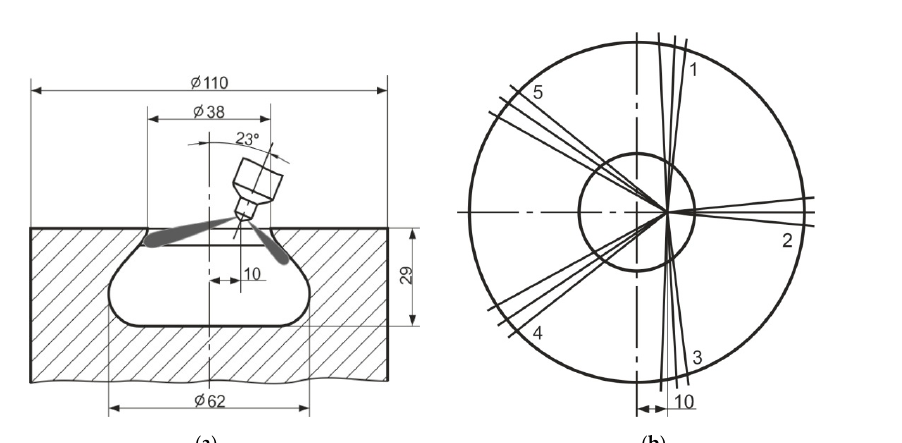
Figure 2. Combustion chamber of D-243 with injector location scheme ( a ) and orientation of fuel sprays in combustion chamber ( b ); 1, 2, 3, 4, 5 are the number of fuel sprays.